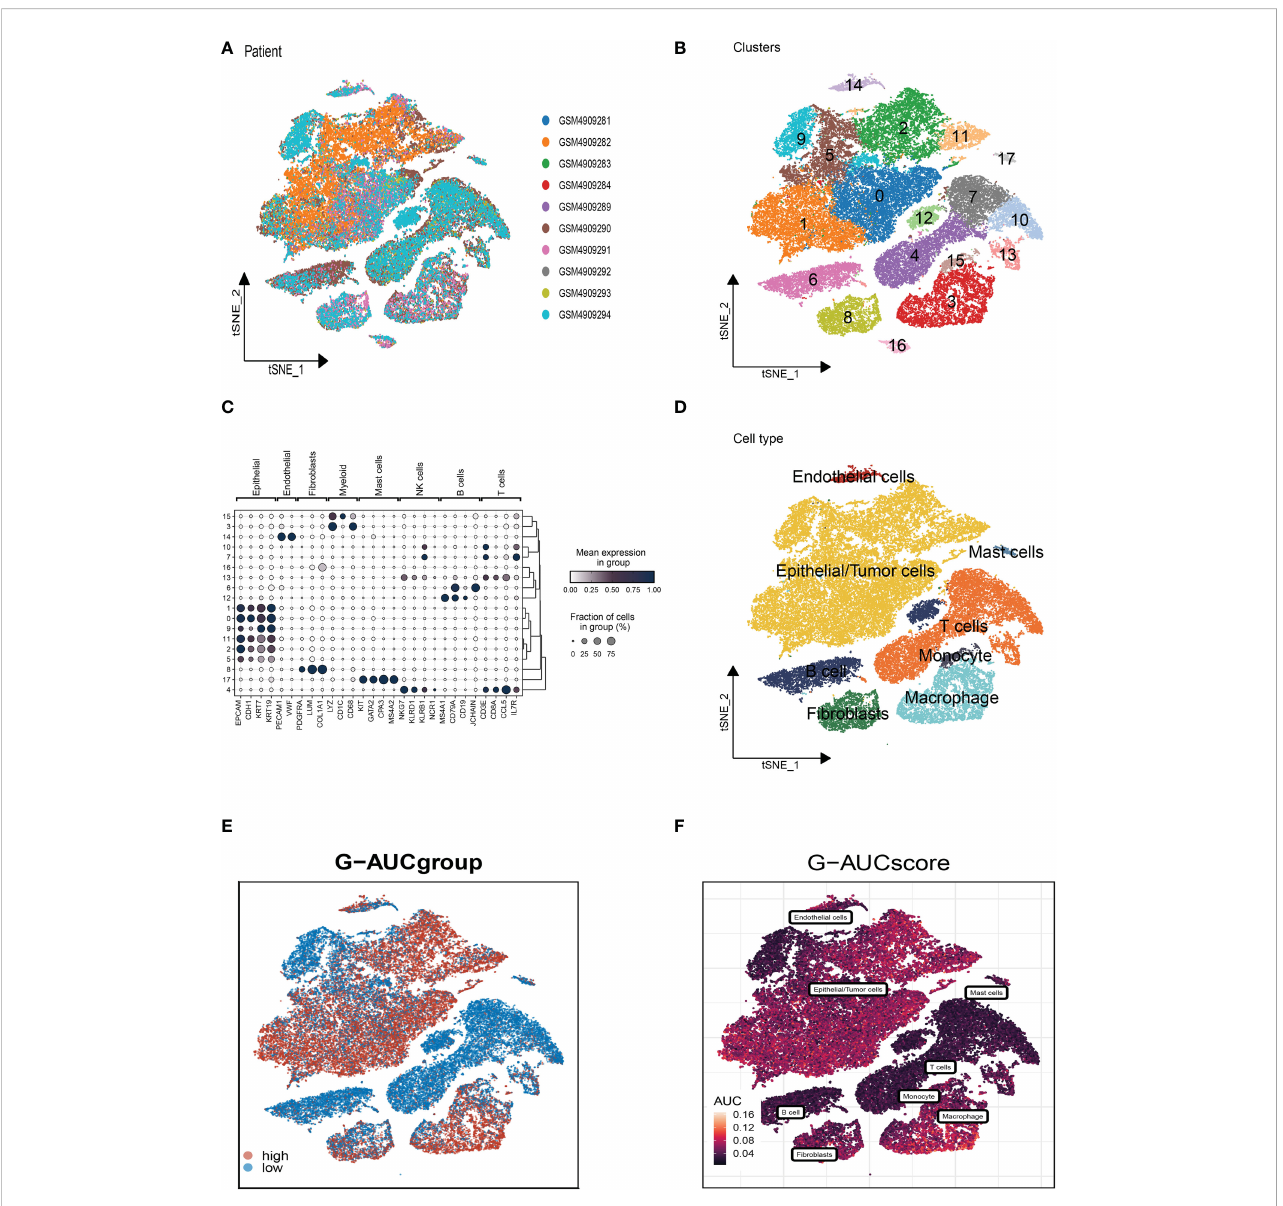
FIGURE 2 Annotation of cell subsets from single-cell sequencing data and identi fi cation of differentially expressed genes. (A) The cell distribution of the samples showed no signi fi cant batch effect. (B) The dimension reduction cluster analysis results are shown in the tSNE diagram. (C) The expression of cell type marker genes. (D) The tSNE map indicates that BC samples can be annotated as 8 cell types in the TME (different colors represent different cell types). (E, F) All cells were scored according to glutamine-associated genes (GRG) and were divided into high and low